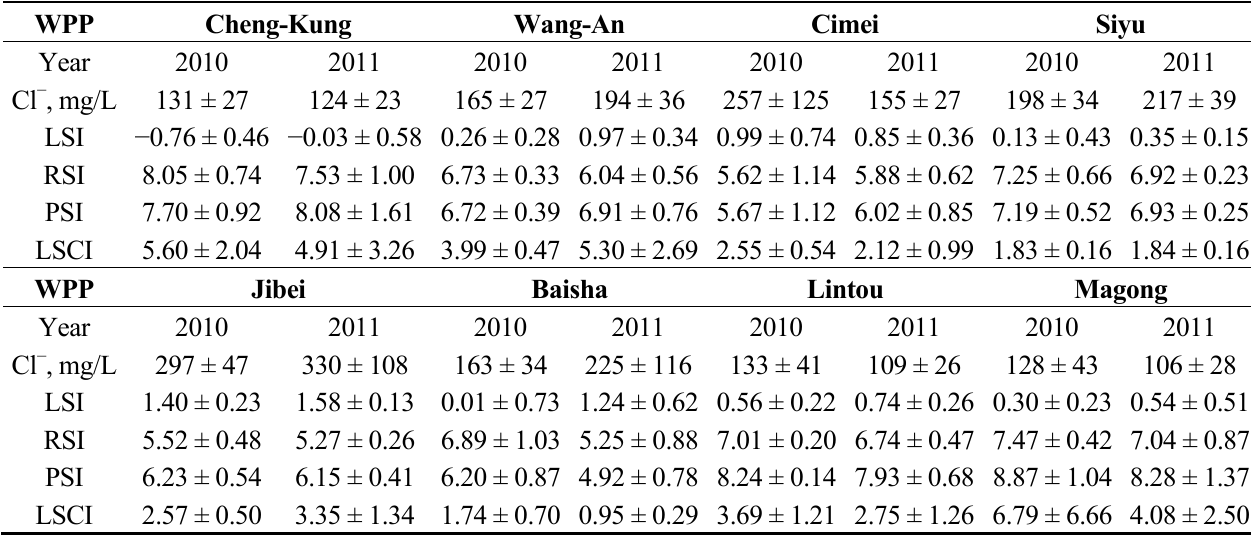
Table 2. Assessment of scaling and corrosion tendency in Penghu County [30,31].